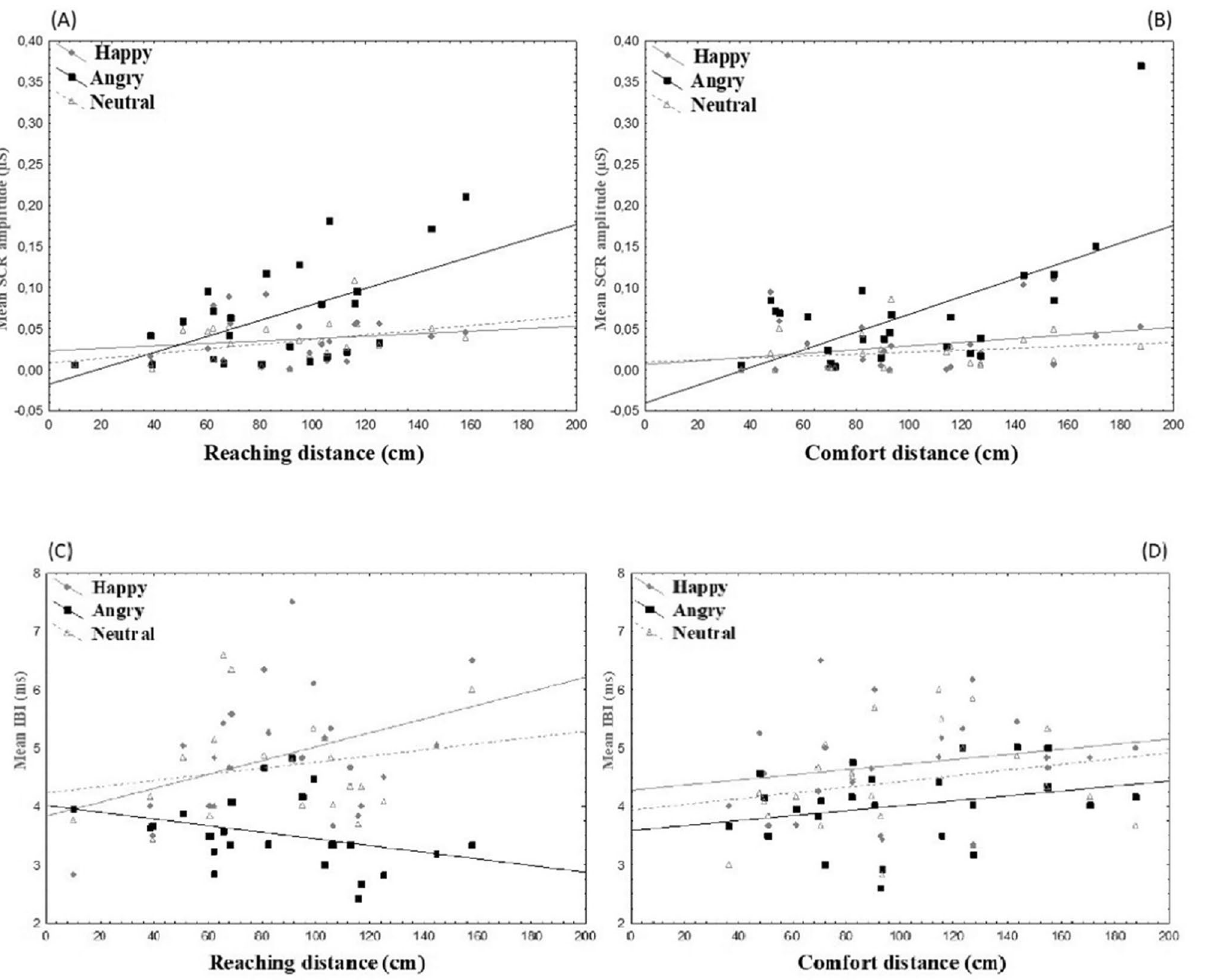
Figure 4. Scatterplots about the relationship between psychophysiological indexes and mean spatial distances. Top , the graphs show SCR amplitude values (μS) for happy, angry and neutral facial expressions (ordinate) and mean Reaching (cm; panel A ) and Comfort (cm; panel B ) distances (abscissa); bottom , the graphs show the Inter-Beat Interval (ms) values for the happy, angry and neutral facial expressions (ordinate) and the mean Reaching (cm; panel C ) and Comfort (cm; panel D ) distances